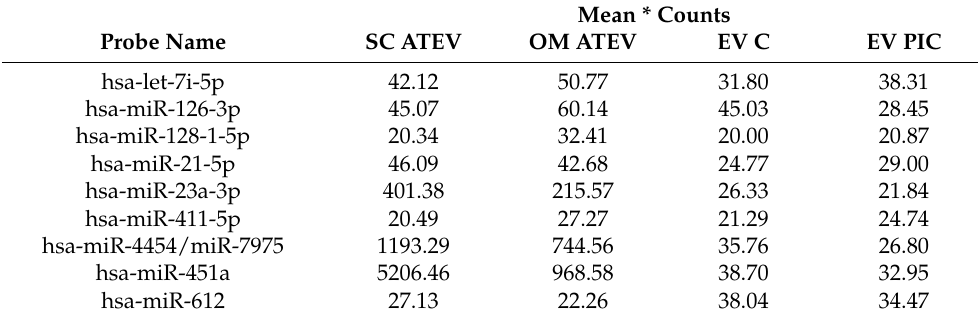
Table 10. miRNA detected in both ATEV and HAMVEC EV C and EV PIC.